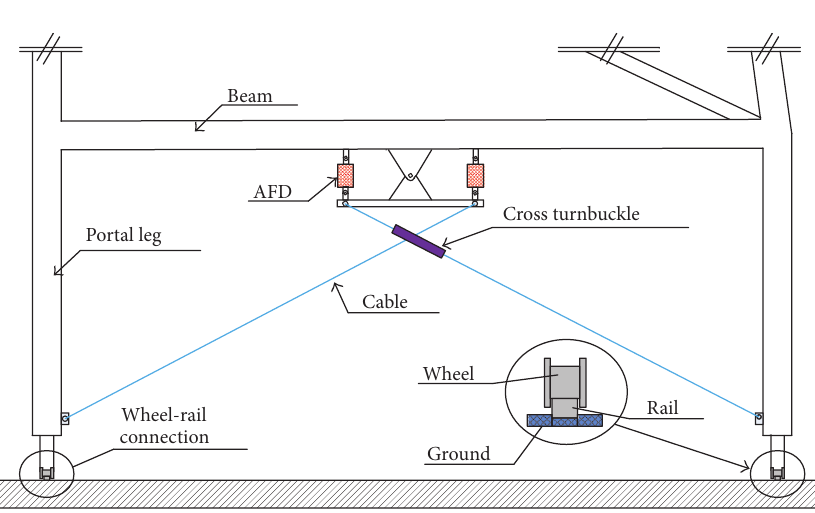
Figure 8: Container crane with AFDs.